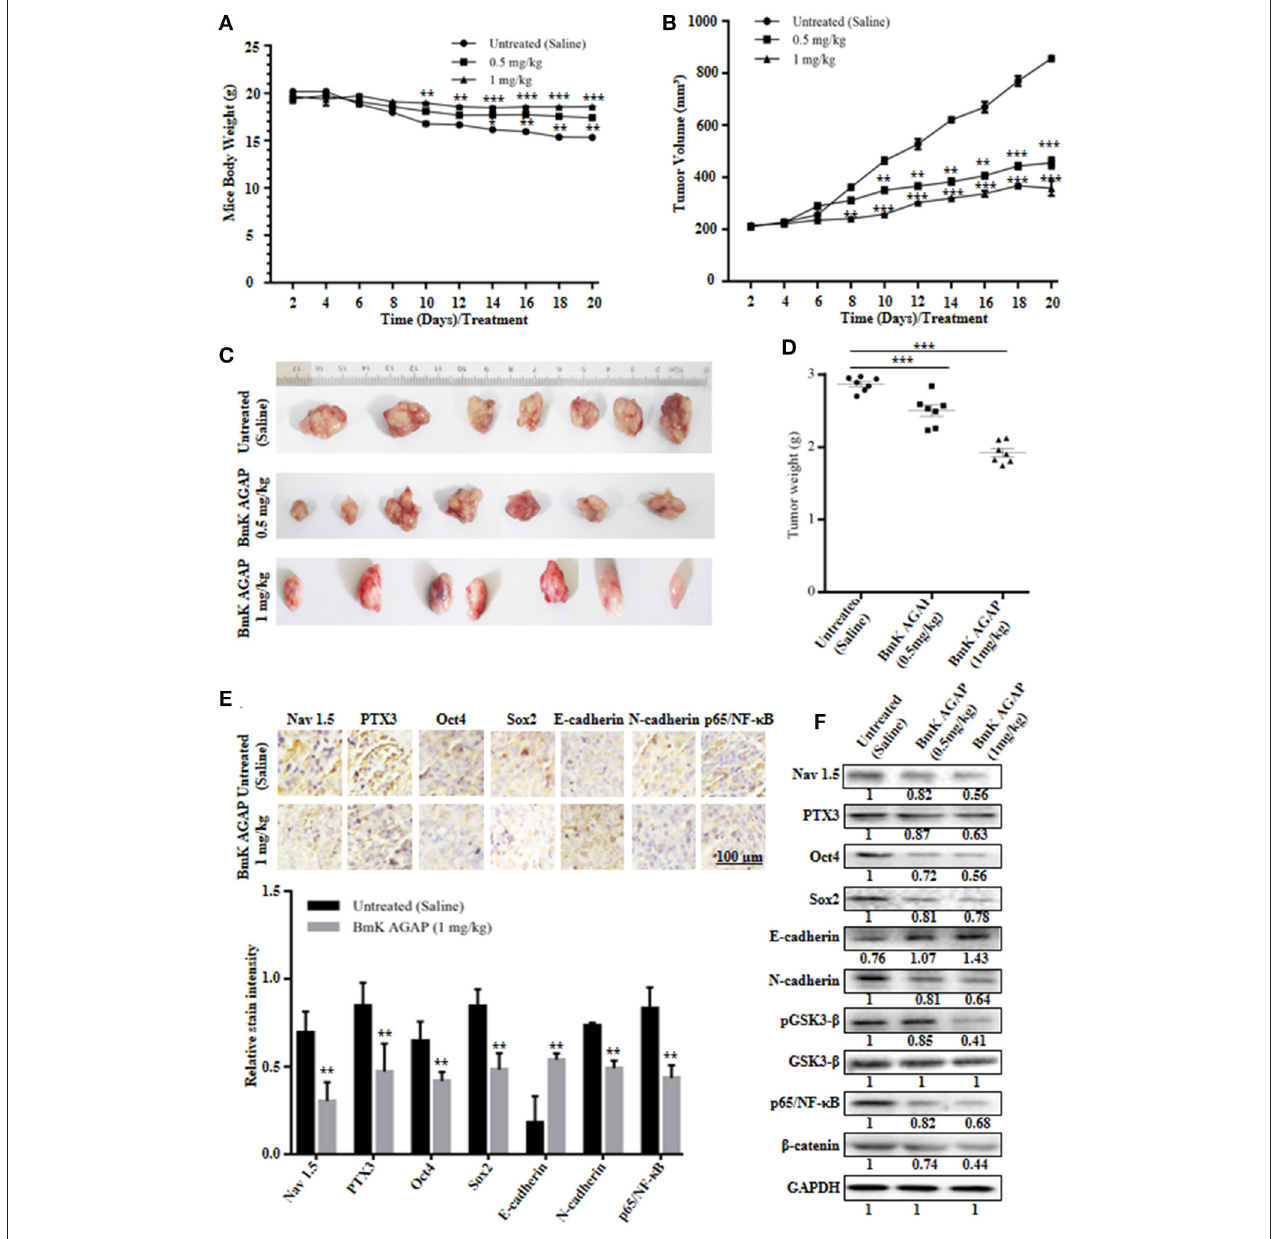
FIGURE 7 | BmK AGAP inhibits the growth of breast xenograft tumors, stem-like features and epithelial-mesenchymal transition in a mouse model. (A) Weight changes in rBmK AGAP-treated and untreated tumor model mice. BALB/c nude mice were treated with rBmK AGAP or saline and the changes in body weight of mice bearing xenograft tumors were examined for 20 days. (B) Tumor volume of tumors from rBmK AGAP-treated and untreated tumor model mice. Xenograft tumor volume were calculated from measuring the length, height and width of tumors using digital caliper following rBmK AGAP treatment. (C) Image of excised xenograft tumors from the different treatment groups after 20 days of tumor implantation. (D) Quantitative analysis of excised tumor weight. Tumors excised from tumor-bearing mice sacrificed after day 20 were weighed on a digital weighting apparatus. (E) Immunohistochemical assessment of stemness, EMT, and inflammation markers in excised tumor tissues. Xenograft tumor tissues were stained with antibodies against Nav 1.5, PTX3, Oct4, Sox2, E-cadherin, N-cadherin, and p65/NF- κ B and examined by immunohistochemical staining (Scale bars = 100 µ m; magnification, 200x). (F) Protein expression assessment of PTX3, stemness, EMT, Wnt/ β -catenin pathway and NF- κ B, in excised tumors. Xenograft tumor tissues from rBmK AGAP-treated and untreated mice were lyse. Equal amount of protein samples were subjected to 12% SDS-PAGE and analyzed by western blotting with antibodies against Nav 1.5, PTX3, Oct4, Sox2, E-cadherin, N-cadherin, pGSK3- β , GSK3- β , p65/NF- κ B, and β -catenin. GAPDH was used as an internal control. The data was statistically significant at * P < 0.05; ** P < 0.01; and *** P < 0.001 as compared to untreated group. The data represent mean ± SD of three independent experiments.